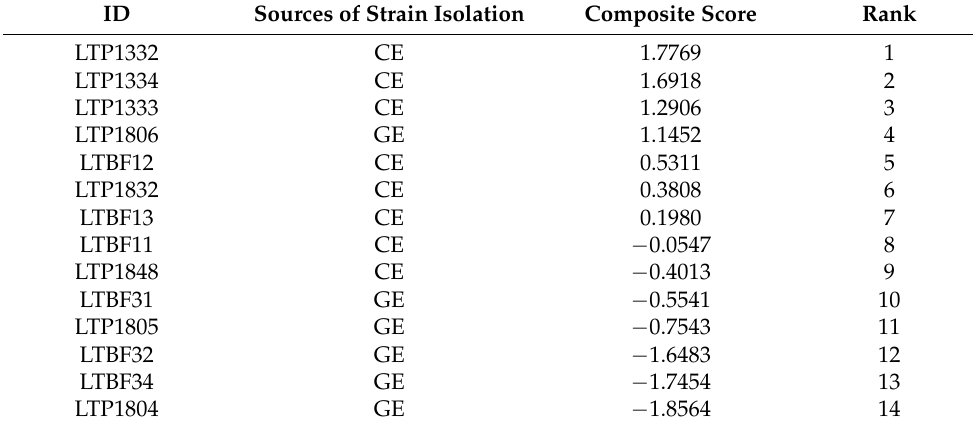
Table 3. Combined score